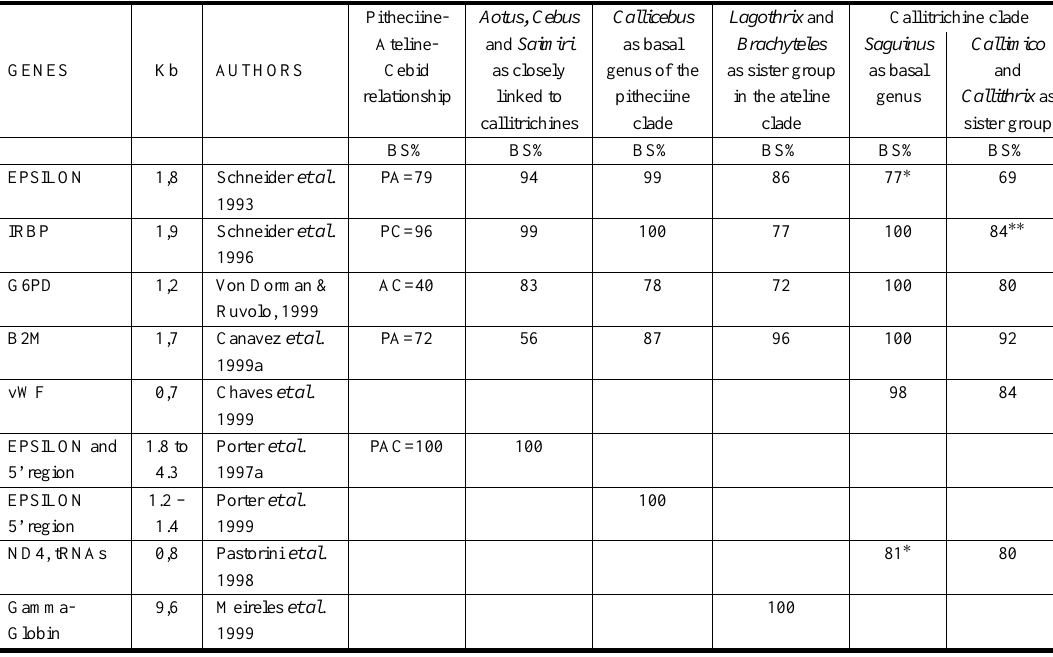
DNA Studies that Elucidate New World monkeys Phylogeny Pitheciine- Aotus, Cebus